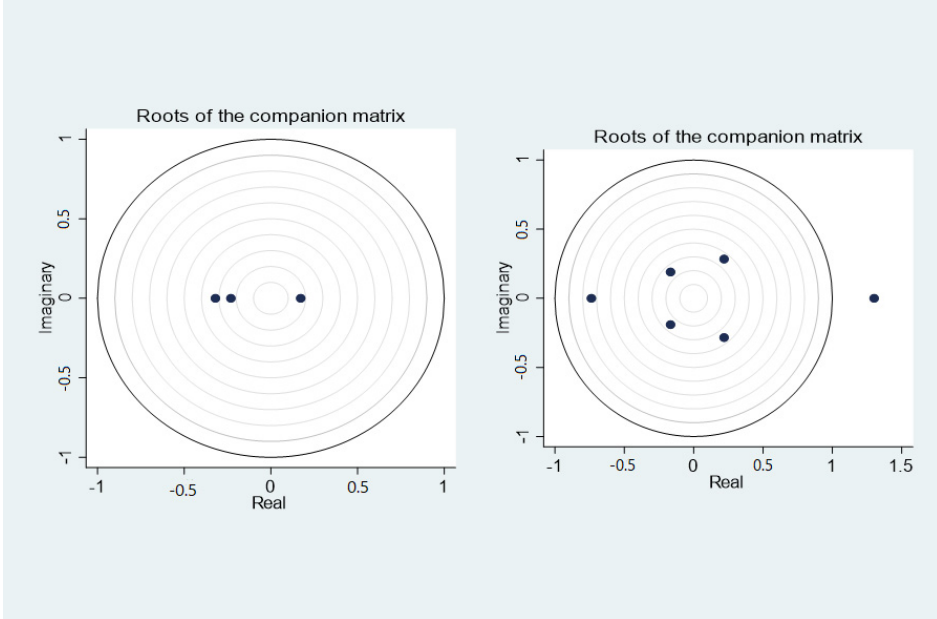
Figure 1. Stationarity test of the PVAR model (left is first-order difference first-order lag, and right is first-order difference second-order